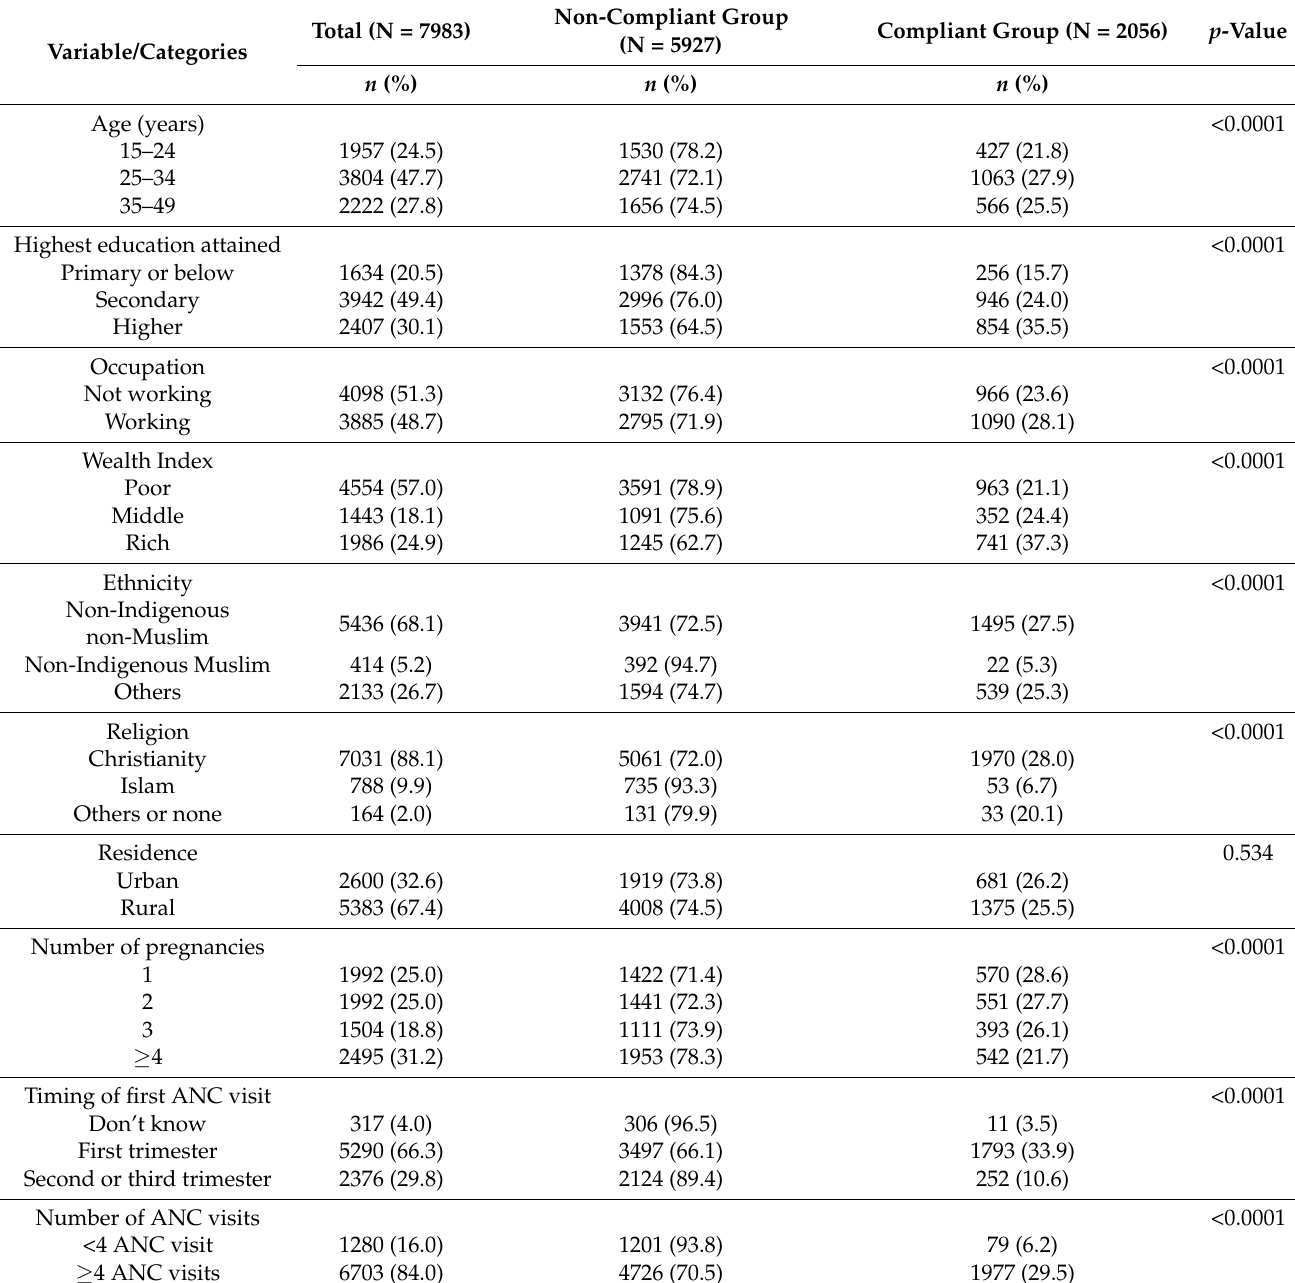
Table 1. The sociodemographic characteristics and selected survey responses by the number of days of iron-folic acid